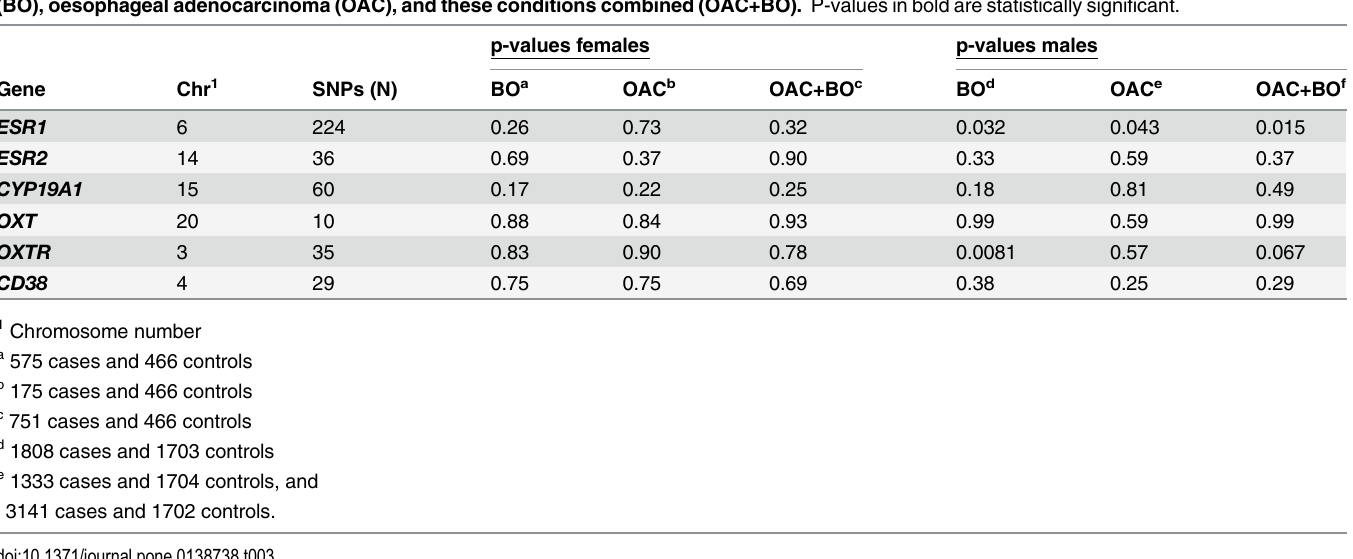
the top 90% SNPs within each gene using the VEGAS test, variants in ESR1 were possibly asso- ciated with an increased risk of BO and OAC combined in males and females (p = 0.0063) (Table 4). In males, a corresponding potential association was found with BO (p = 0.0058), which was statistically significant with BO and OAC combined (p = 0.0023) (Table 5). The